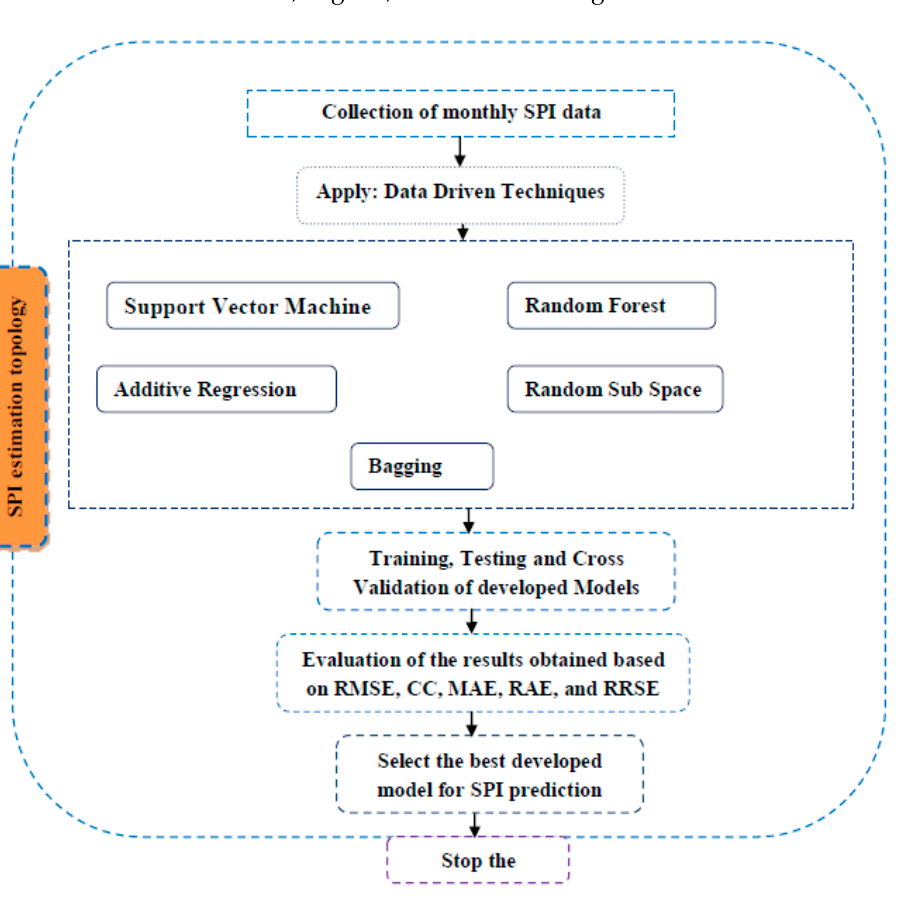
Figure 2. Flowchart of the proposed methodology.